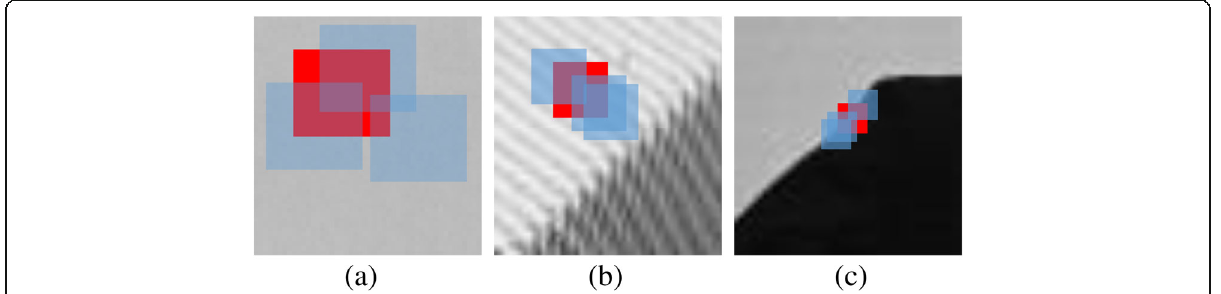
Fig. 2 Illustration of image blocks with three morphological components, i.e., with a smooth, b texture, and c contour components, respectively